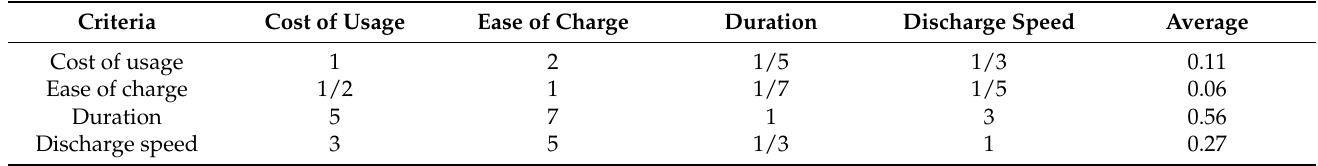
Table 6. Criteria relative